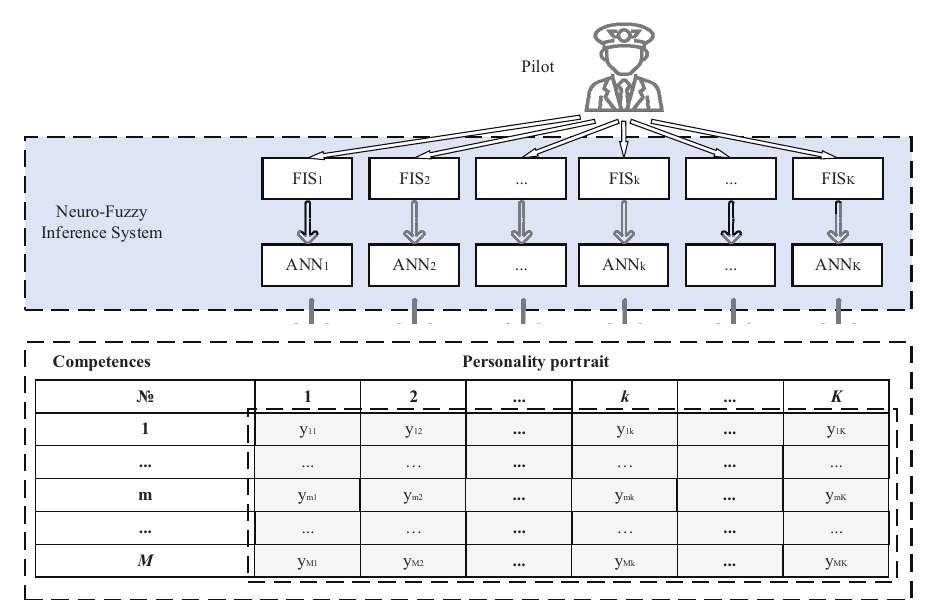
Figure 1. Formation scheme of entrant’s personality portrait in the requirements space to the specialist